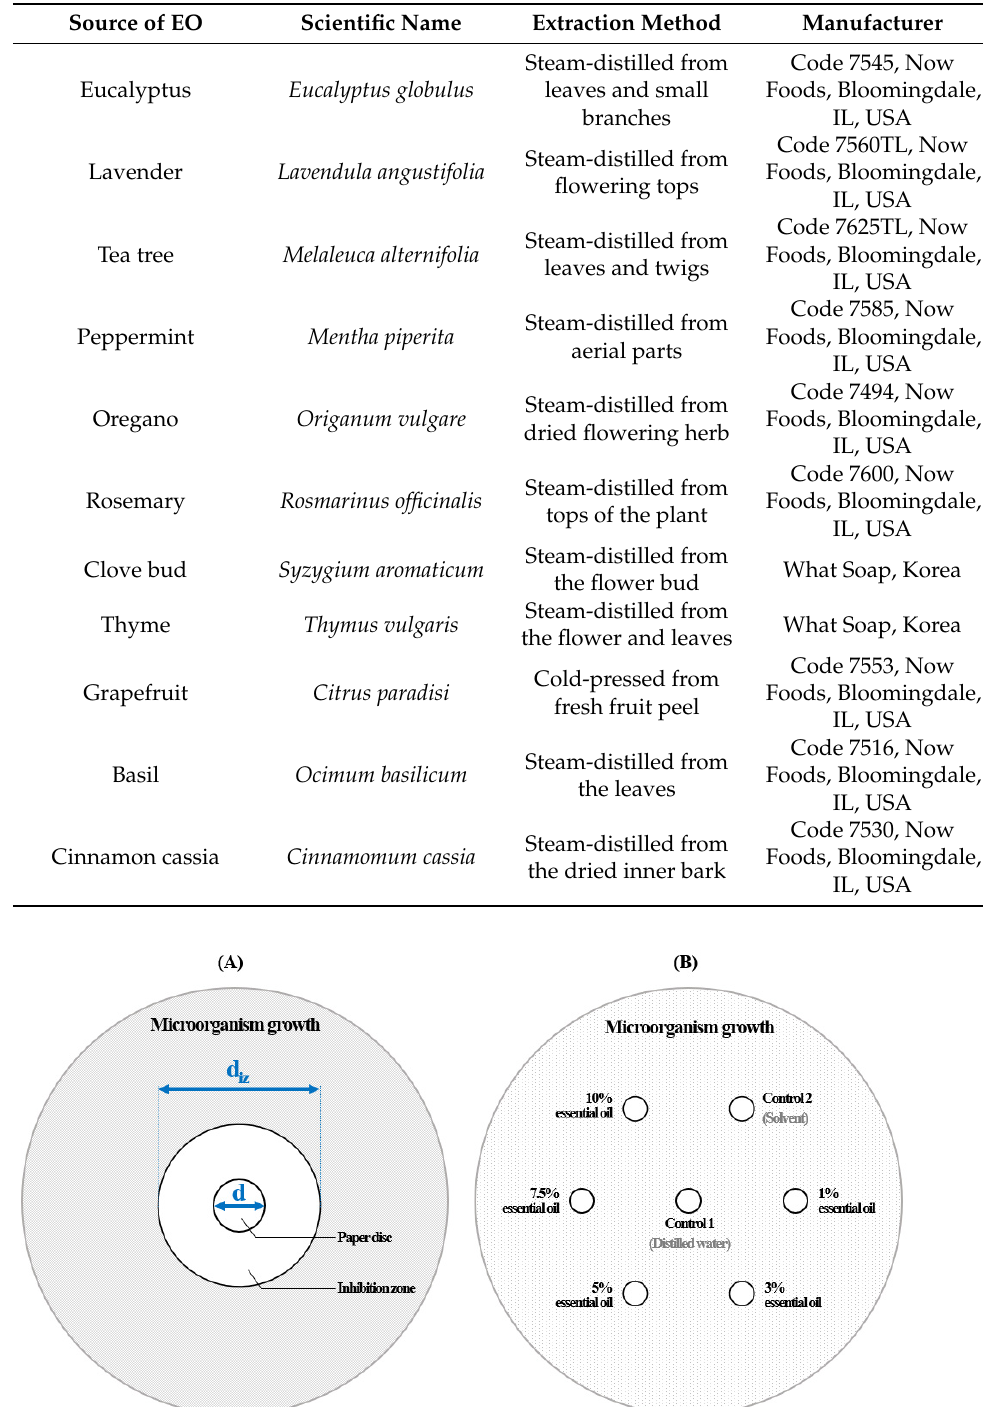
Table 1. List of selected essential oils containing natural biocide substances.